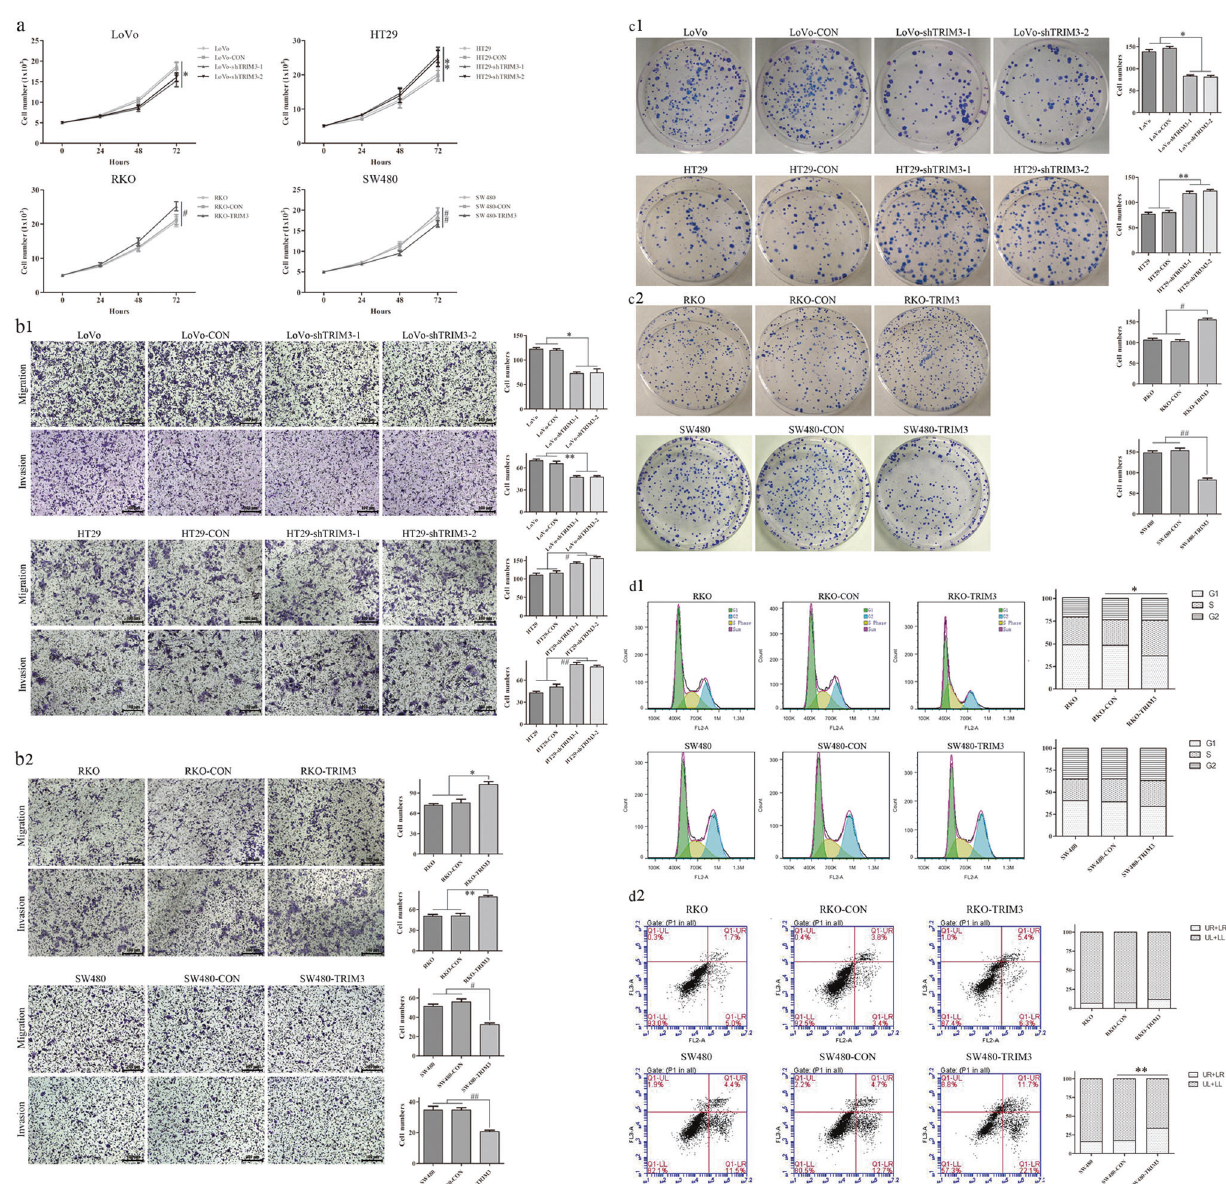
Fig. 2 The dual neoplastic features of TRIM3 related with CRC cells status of wild or mutant p53. a The growth curves of CRC cells with TRIM3 knockdown or overexpression by CCK8; b1 The number of cell migration and invasion of CRC cells with TRIM3 knockdown; b2 The number of cell migration and invasion of CRC cells with TRIM3 overexpression; c1 The number of colony formation of CRC cells with TRIM3 knockdown; c2 The number of colony formation of CRC cells with TRIM3 overexpression; d1 The effects of TRIM3 overexpression on cell cycle in RKO and SW480 cells by fl ow cytometry; d2 The effects of TRIM3 overexpression on cell apoptosis in RKO and SW480 cells by fl ow cytometry; wtp53 cells: LoVo, RKO; mutp53 cells: SW480, HT29; All data were obtained from three independent experiments, and expressed as mean ± standard deviation. *, ** and # , ## P < 0.05 in comparison with control groups.